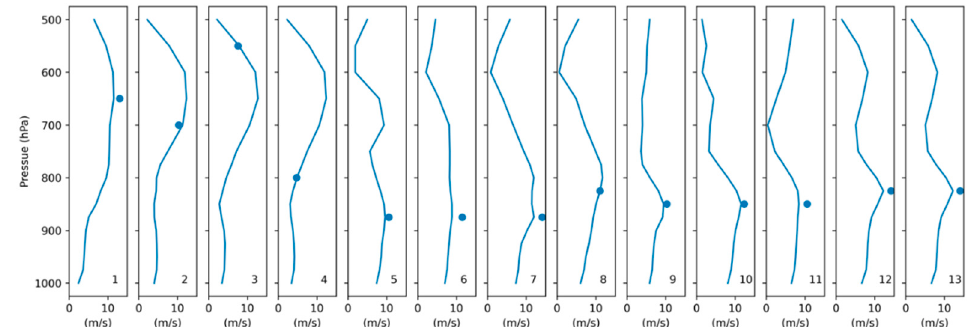
Figure A2. Comparisons of spatially and temporally collocated ERA5 wind-speed magnitudes (calculated from u and v components) against in-plume horizontal velocity retrievals derived from the Farneback optical flow algorithm. The in-plume horizontal velocity is matched to the closest ERA5 velocity across pressure levels, with most plumes injecting near 850 hPa (~1.5 km above mean sea level), the height value assumed in [44].